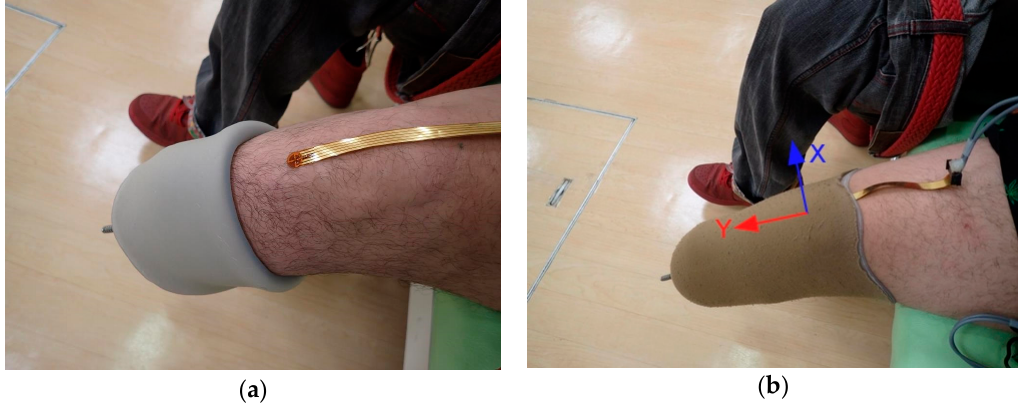
Figure 13. Photographs showing how the sensor was attached to the stump in the prosthesis liner: ( a ) Sensor head of the shear force sensor was attached to the tibial tuberosity with a double-sided adhesive tape, and the measurement started; and ( b ) The prosthesis liner was fully donned.